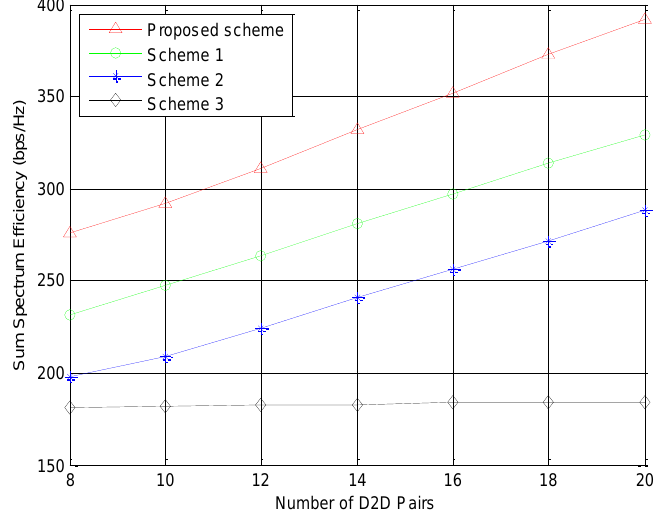
Figure 6. The sum spectrum efficiency versus the number of D2D pairs K .